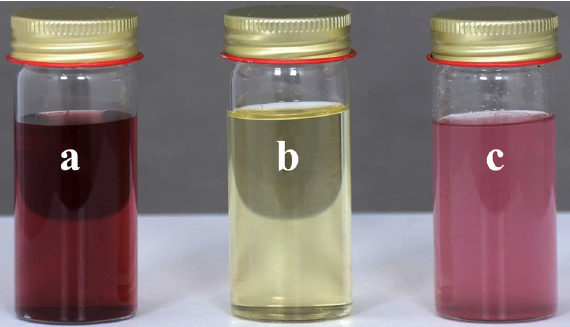
Figure 1: Samples: ( a ) AuNPs preparation, ( b ) CHR solution, and ( c ) CHR – AuNPs preparation.